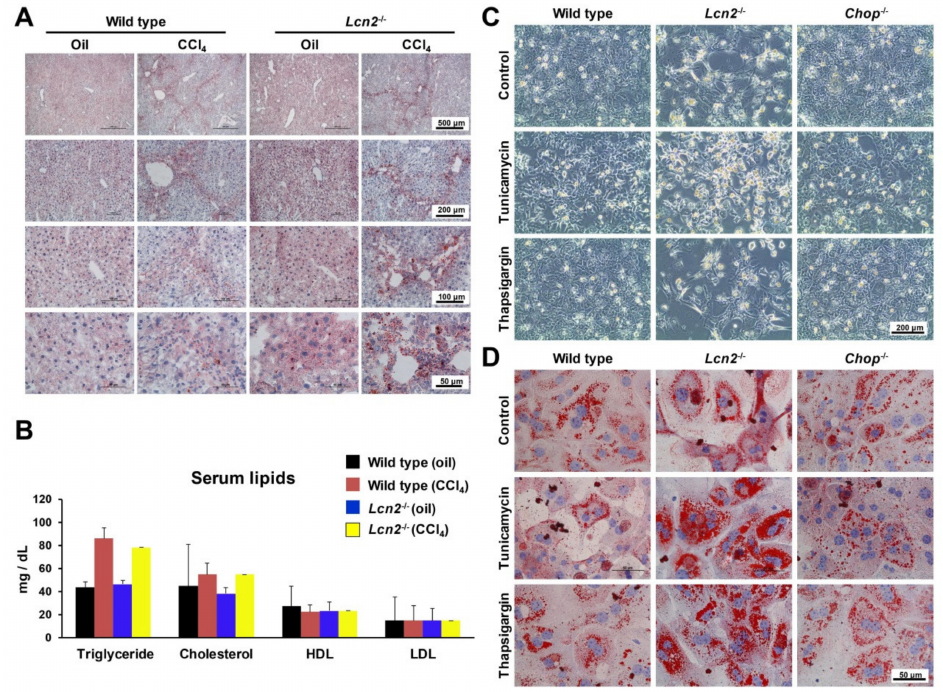
Figure 3. ER stress-induced steatosis. ( A ) Oil Red O-stained liver slides showing slightly increased amounts of lipid droplets in oil- and CCl 4 -injected Lcn2 − / − mice compared to wild type